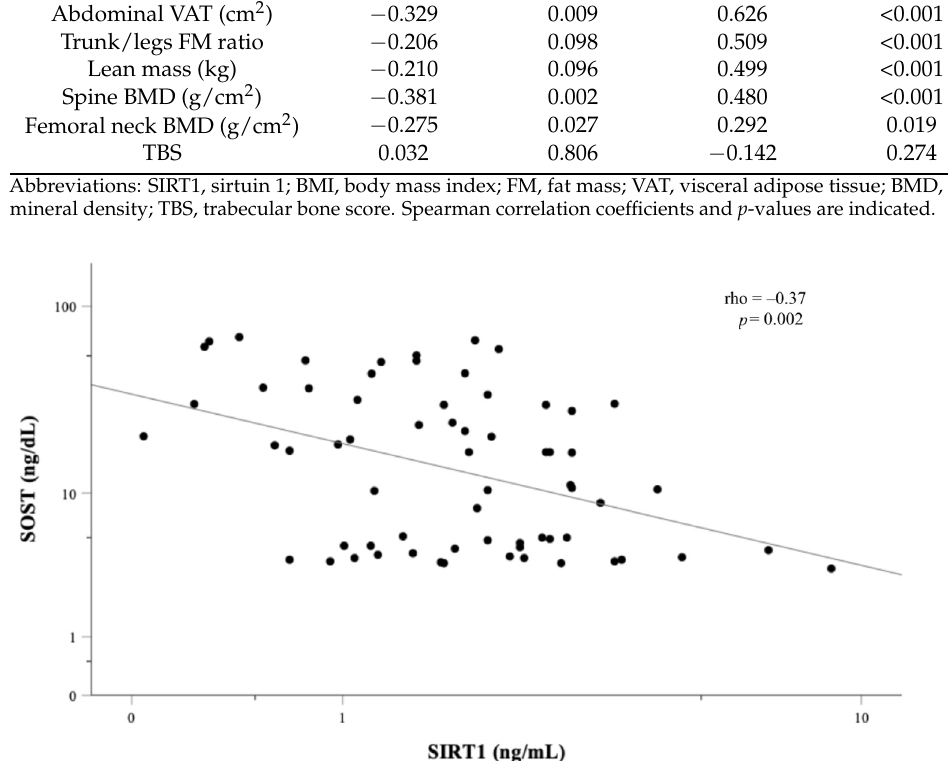
Table 2. Linear correlation analyses between SIRT1 and sclerostin and indicators under considera- tion.